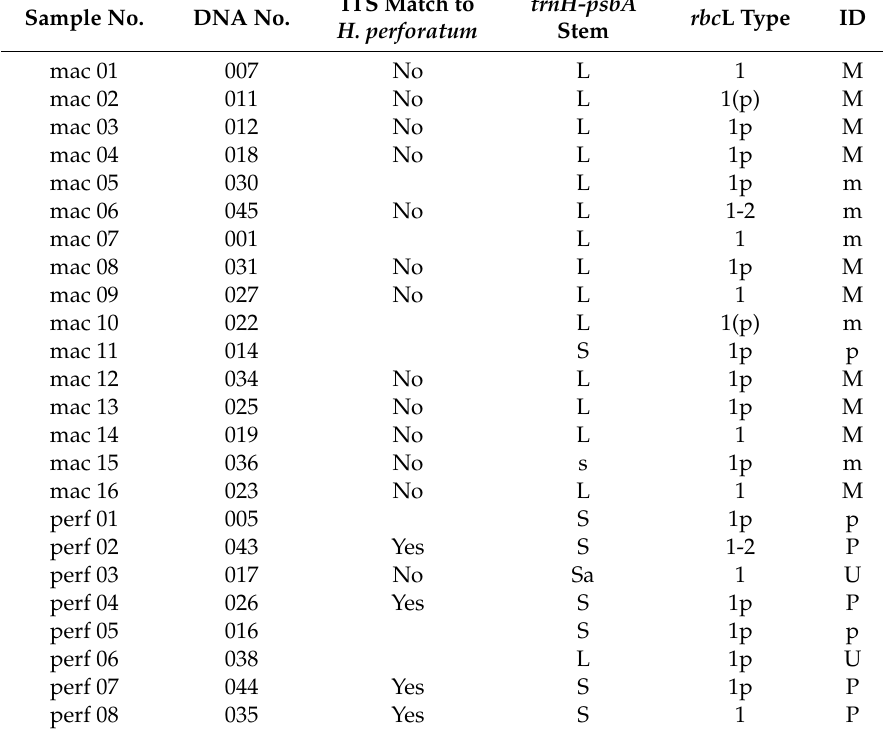
Table 5. Test plant samples of H. perforatum and H. maculatum [56]. The sample number indicates